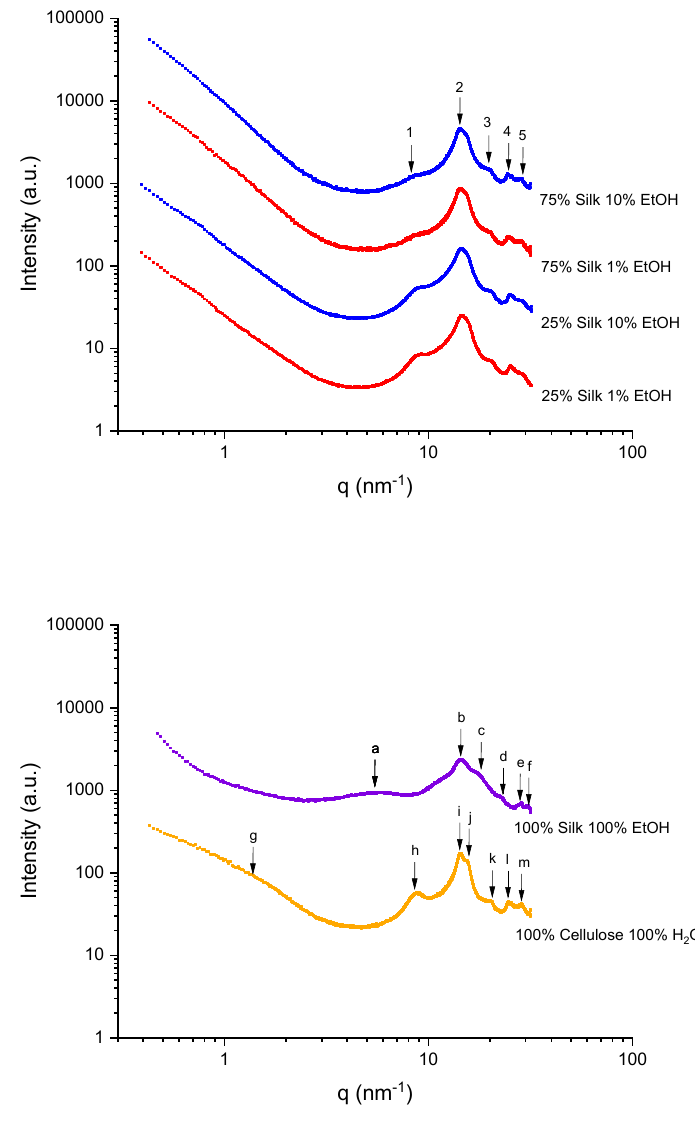
Figure 6. Scattering profiles for varied composition biocomposites and 100% regenerated silk and cellulose samples. Table 4. Scattering vector and correlation distances for two varied composition silk/cellulose biocomposites coagulated with two different coagulation agents.